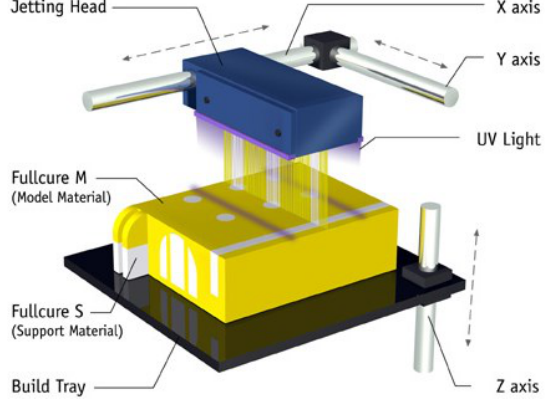
Fig. 3 The principle of PolyJet Matrix method [9]